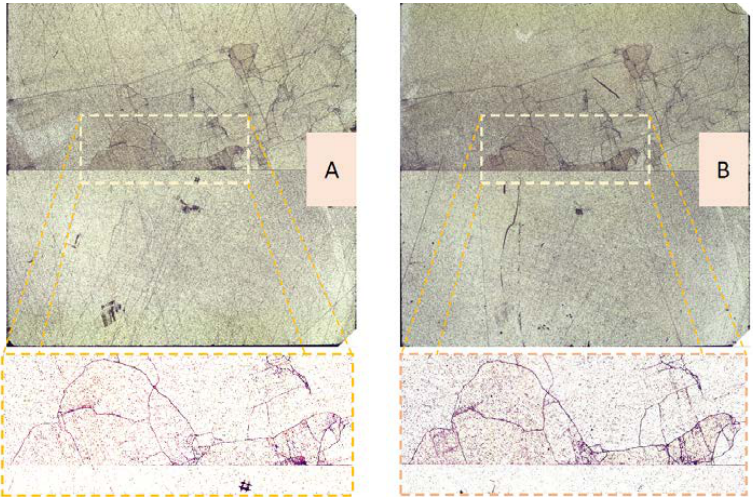
Figure 10. AFM “3D” topography of the representative etch pits on the surface of SrTiO 3 (100) for different interaction time between the crystal and etchant (here HF) ( a ). The diagram on the upper right ( a ) shows the linear increase of the average depths of the etch pits as a function of etching time. Cross sections of selected etch pits (for different etching time ( b )) do not correspond with classical linear inclination (slope) of the facets, rather the cross-sections have a typical shape for a funnel (see insert on right). Only for two etch pits the mentioned linear inclination has been found (cross sections marked with green lines). The deviation from the planarity of the shape of etch pits facets is a consequence of the change of the etching yield for the hierarchical tree of dislocations ( c ), where the concentration of dislocations is dramatic reduced between surface layer and interior of the crystal (for details see [10,42,68]).